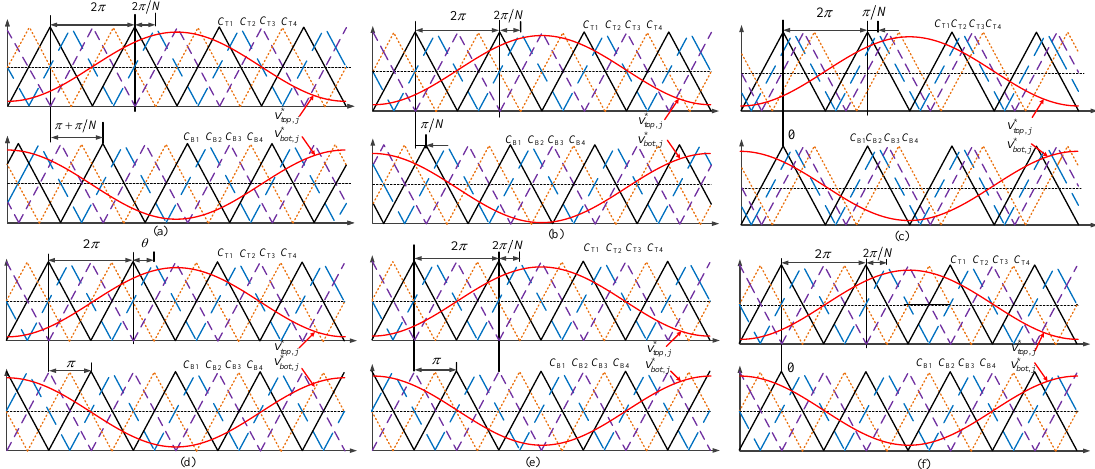
Figure 5. Proposed PSC-SPWM schemes for MMC that achieve maximal voltage harmonic elimination or maximal circulating current harmonic elimination. ( a ) PSC-SPWM1. ( b ) PSC-SPWM2. ( c ) PSC-SPWM3. ( d ) PSC-SPWM4. ( e ) PSC-SPWM4 when θ 1 = 2 π / N . ( f )